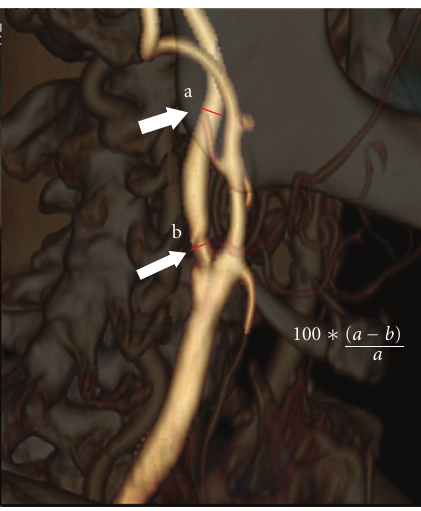
Figure 1: Volume rendering CT angiography showing measure- ment of internal carotid artery stenosis. Following the NASCET criteria, a measure of the ratio at the point of greatest stenosis (small white arrow) and at the normal part of the artery beyond the carotid bulb (big white arrow) was